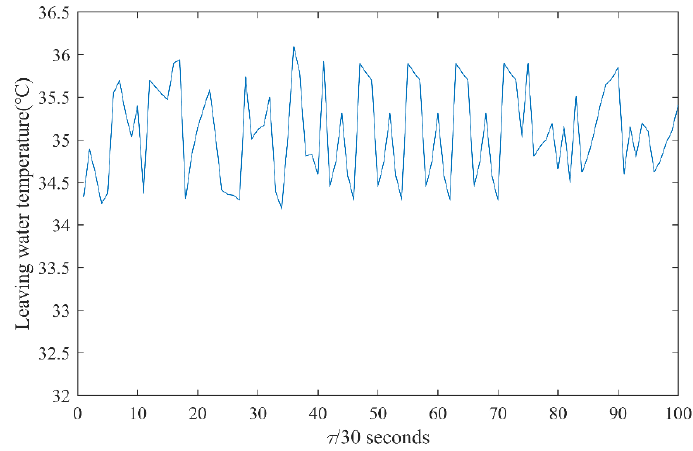
Figure 3. E ff ects of heat source outlet water temperature Figure 3. Effects of heat source outlet water temperature control.